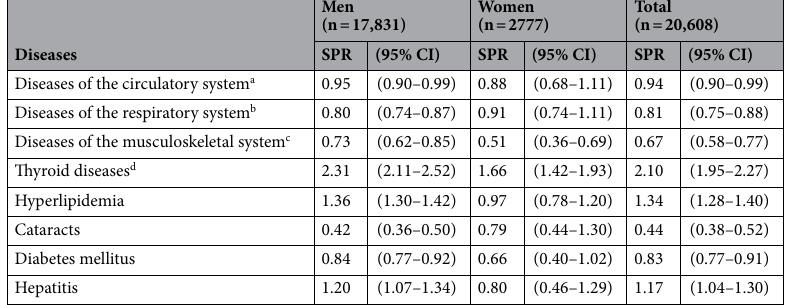
Table 2. Age- and sex-specific standardized prevalence ratios (SPRs). CI confidence interval. a Including hypertension, stroke, myocardial infarction, and angina. b Including pulmonary tuberculosis and asthma. c Including rheumatoid arthritis and osteoporosis. d Including benign thyroid tumor, thyroid nodule, thyroid goiter, thyroiditis, hyperthyroidism, and